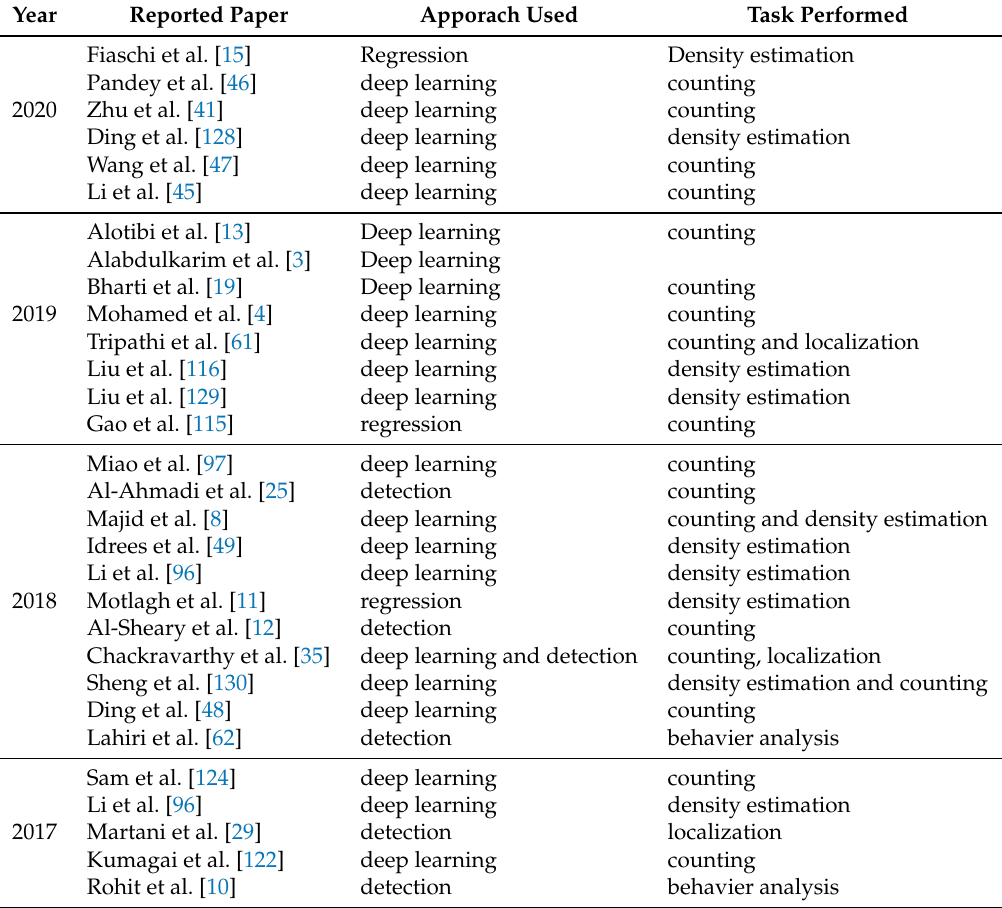
Table 4. Real time CMS, year wise